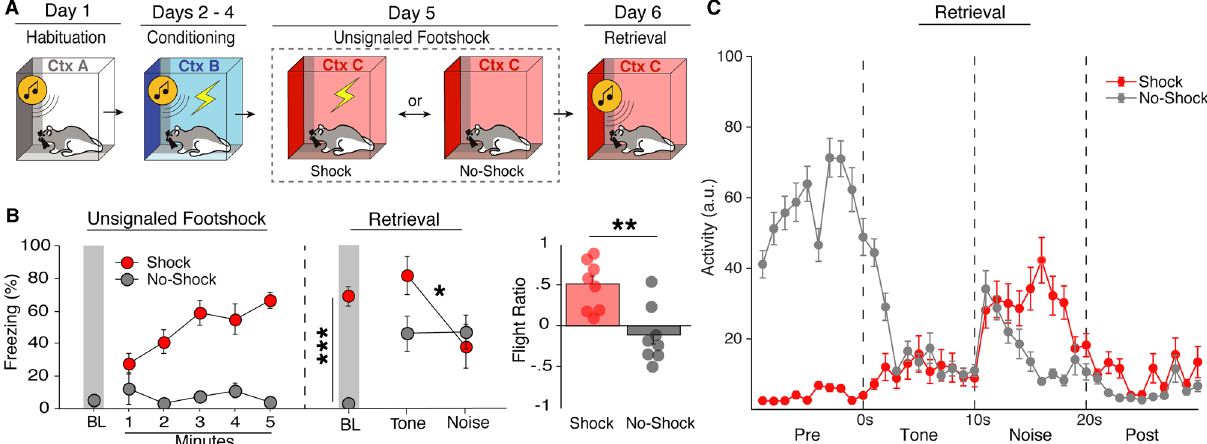
Figure 2. Flight-like behavior depends on context-US associations. ( A ) Behavioral design. ( B ) Average freezing data shows rats that received unsignaled footshocks (Shock) froze at high levels, whereas rats that were merely exposed to the context (No-Shock) froze at low levels. For Retrieval testing, Shock animals showed higher baseline freezing and a decrease in freezing upon white noise onset whereas No-Shock animals showed low baseline levels and remained freezing at moderate levels throughout the SCS. Average flight ratio shows that rats that Shock animals showed a bigger flight response than No-Shock animals. ( C ) Averaged activity data during the first trial of Retrieval for Shock and No-Shock animals. All data are represented as mean ± SEM pooled across sex [Shock ( n = 8); No-Shock ( n = 8)]; *, **, and *** denote p < 0.05, p < 0.01, and p < 0.001,